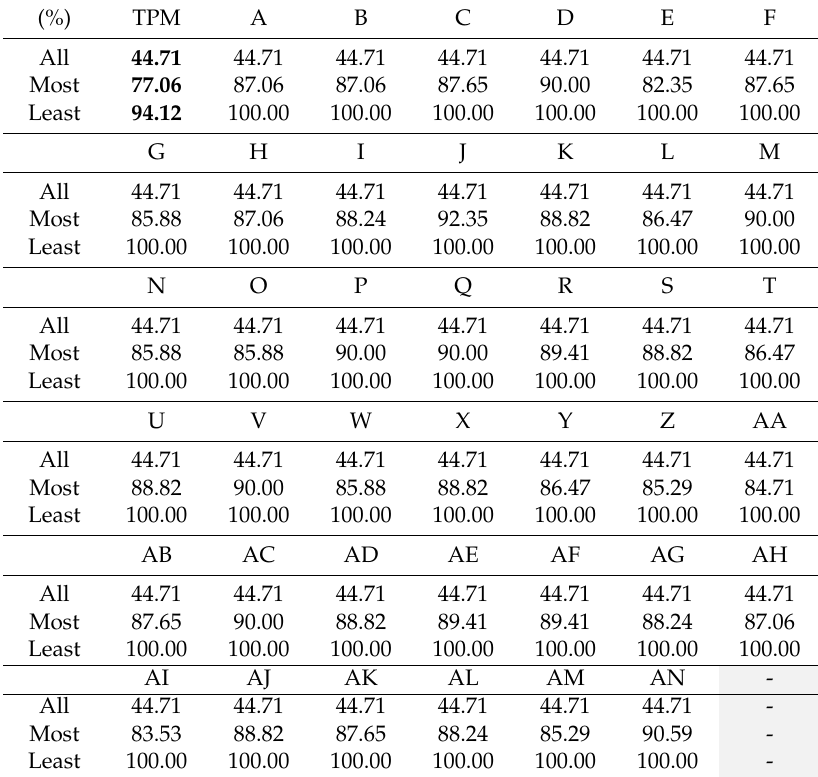
Table 4. Emotion match rates for the “All,” “Most” and “Least”